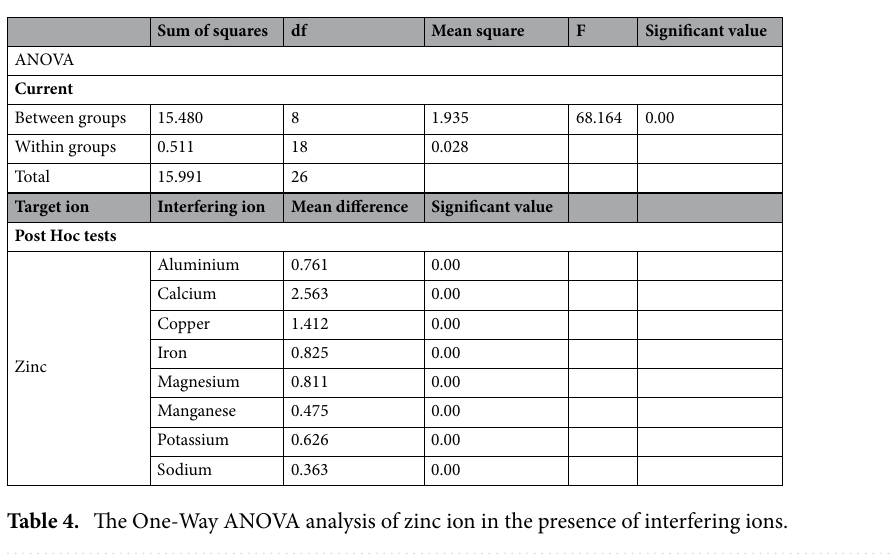
Sum of squares df Mean square